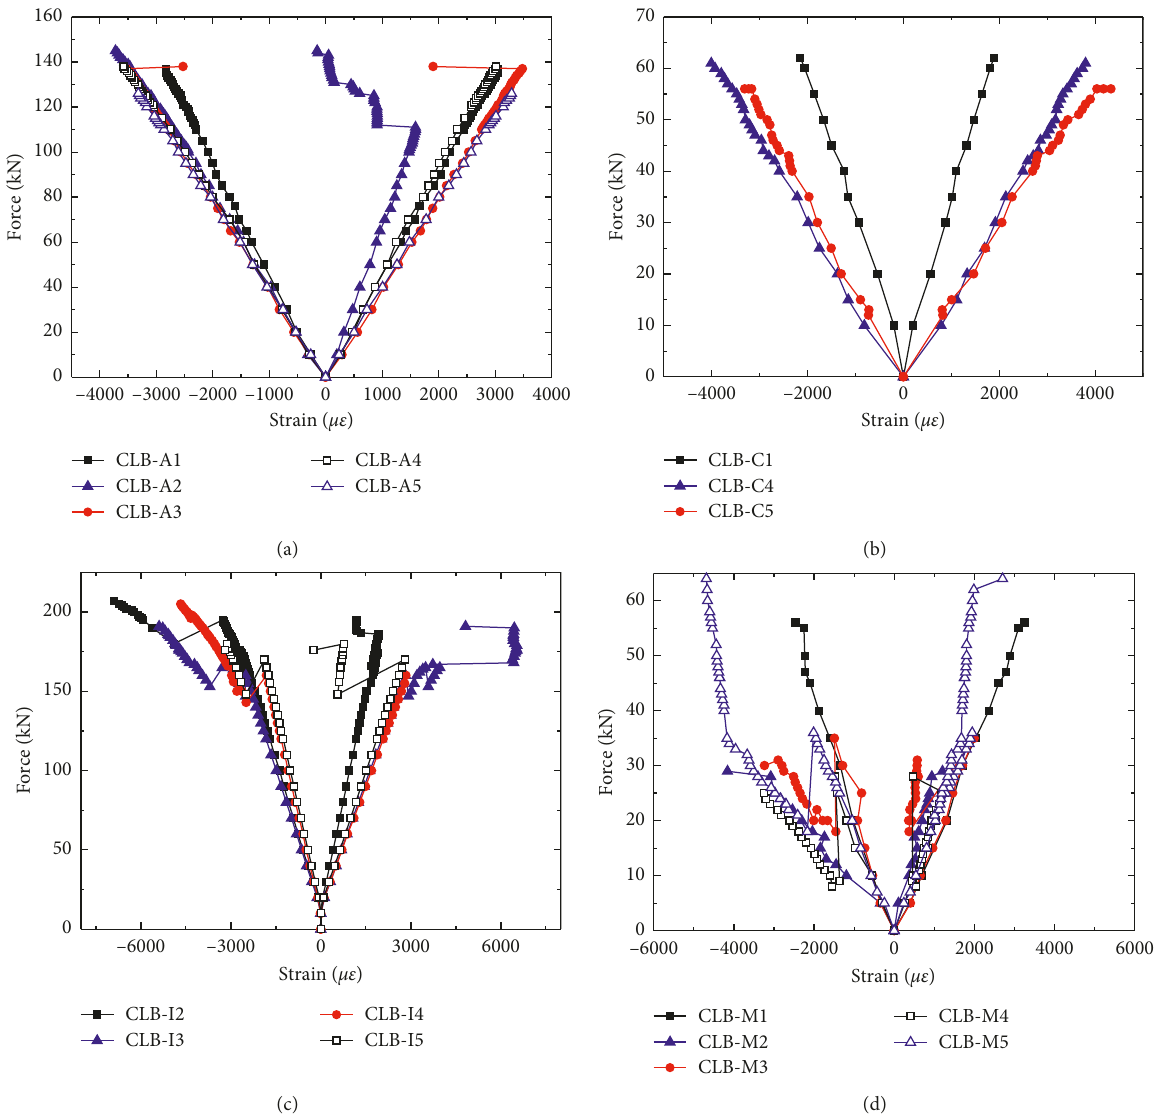
Figure 19: Load-average strain relationships of slab specimens. (a) Group CLB-A. (b) Group CLB-C. (c) Group CLB-I. (d) Group